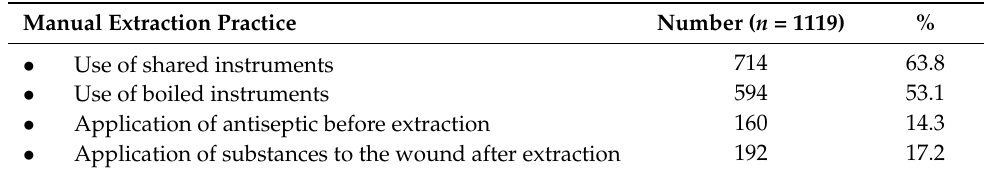
Table 6. Details about manual extraction practice. These questions were only asked if manual extraction was stated as main treatment method ( n =